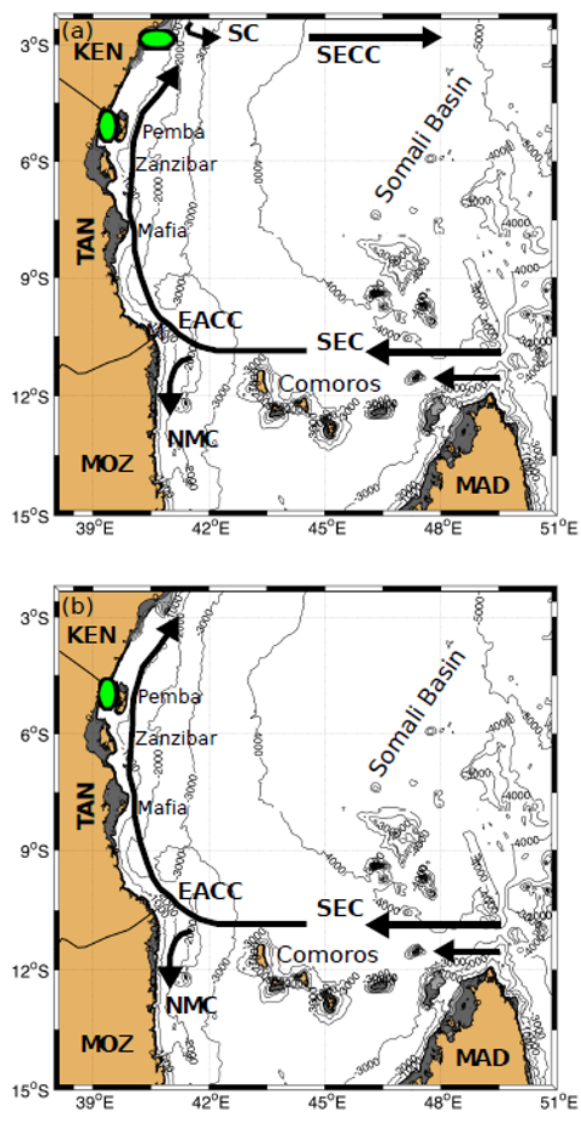
Figure 11. Circulation patterns during (a) the NEM and (b) the SWM, showing the Somali Current (SC), South Equatorial Counter- current (SECC), East African Coastal Current (EACC), South Equa- torial Current (SEC), and Northeast Madagascar Current (NMC). Green ellipses denote upwelling areas. Dark grey shading denotes depths within the 200m isobath, and light grey shading denotes depths from 200 to 500m. Labels on land indicate Kenya (KEN), Tanzania (TAN), Mozambique (MOZ), and Madagascar